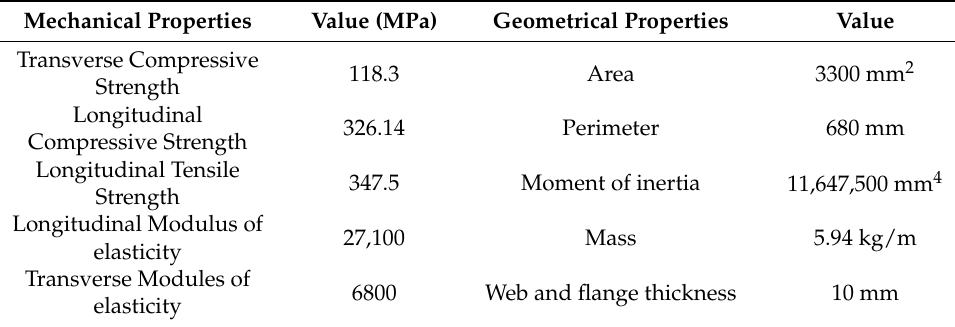
Table 3. Mechanical and geometrical properties of the GFRP I-beam.